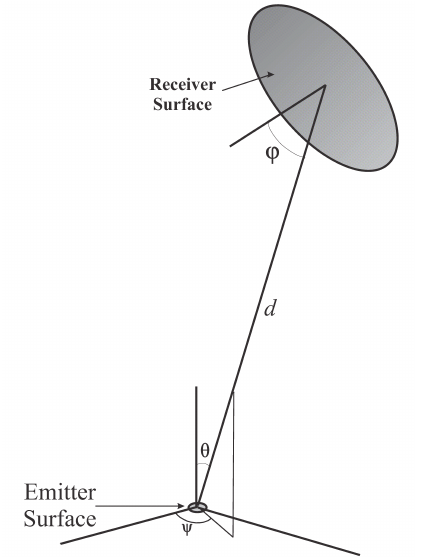
Figure 2. Simplified diagram of the problem of the distance estimation between a camera (Receiver Surface) and a IRED